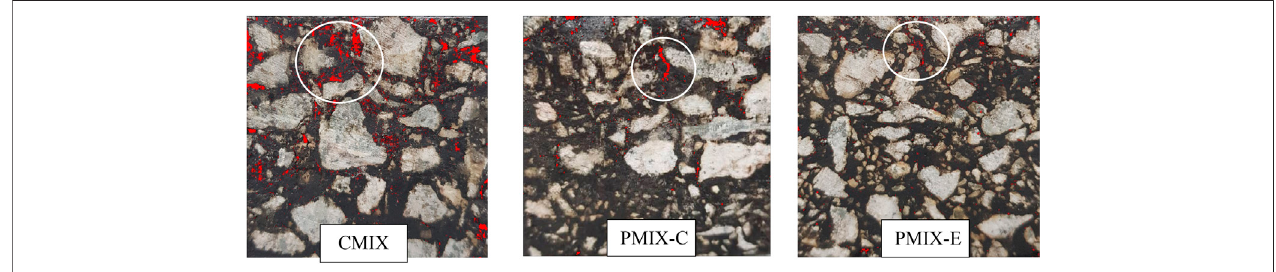
FIGURE 12 | Deformation in asphalt mixtures with macro-cracks on the wheel